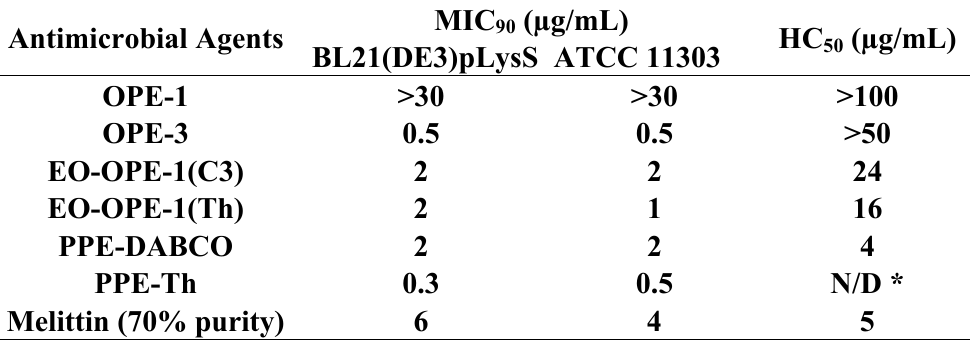
Table 3. Minimum inhibitory concentrations and hemolytic concentrations of the antimicrobial compounds in the